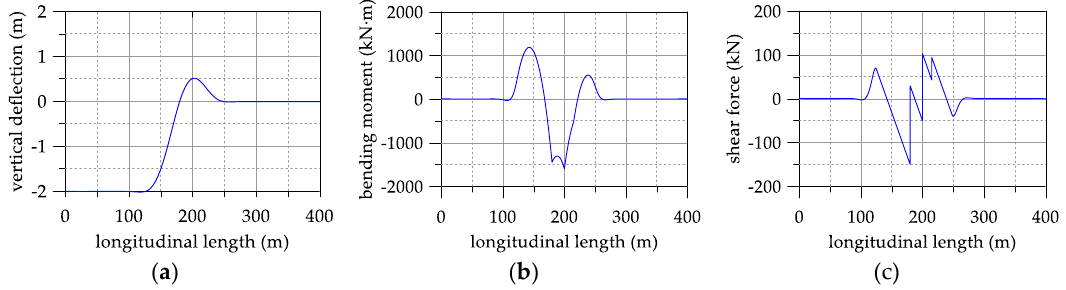
Figure A3. Analysis results of the segmental pipeline model in the vertical plane: ( a ) deflections; ( b )